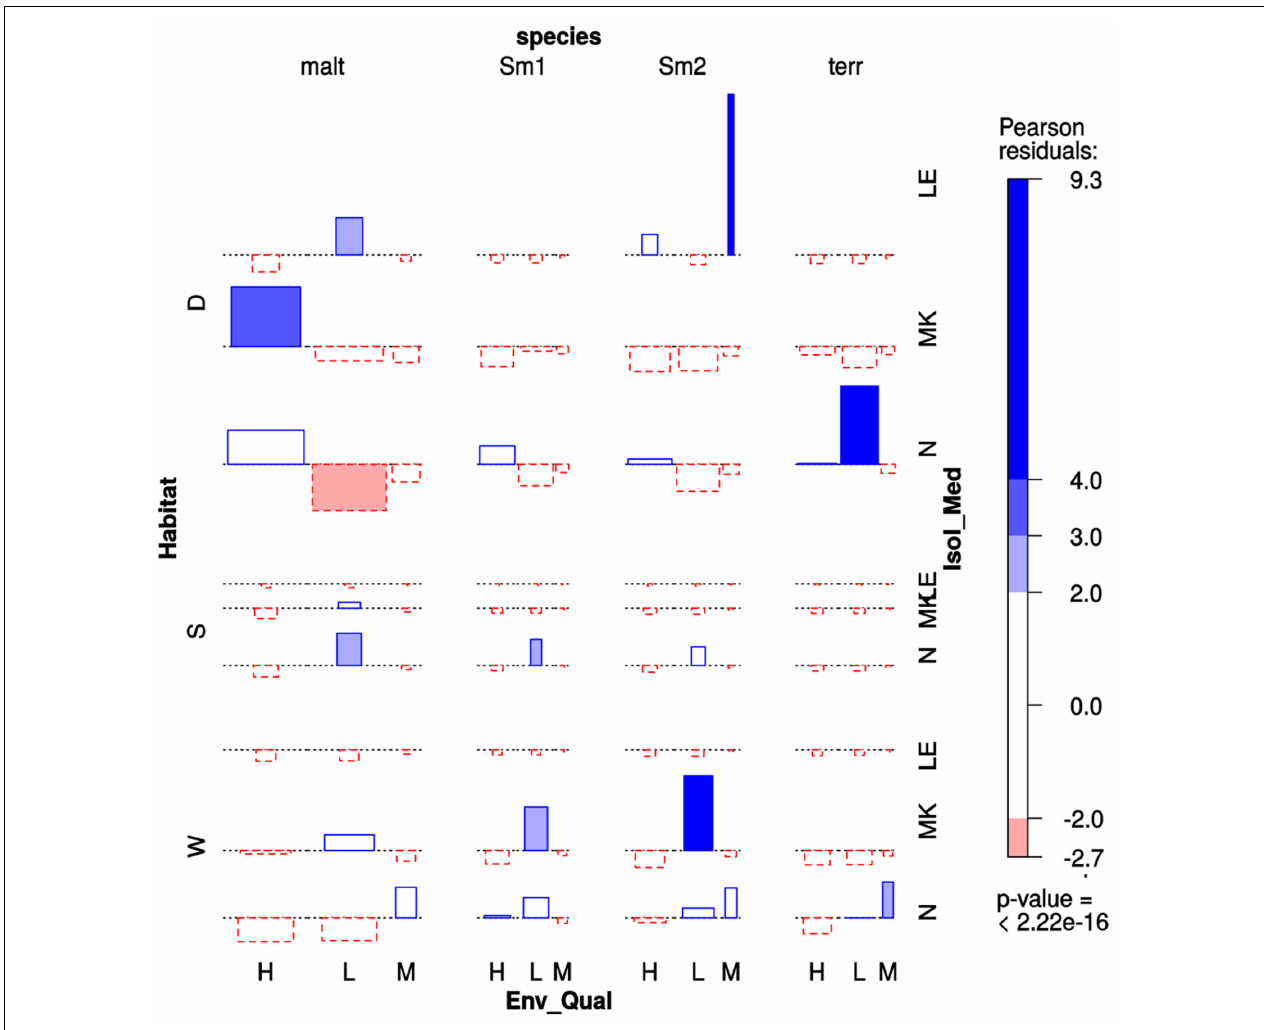
FIGURE 6 | Four-way association plot showing the results of multiway-chi-square analysis for the categorical variables species (abbreviations as defined in Figure 3 ), habitat (W = water column; S = flooded soil; D = sediment), isolation medium (N = NAA; MK = MacConkey; LE = Leed’s Medium) and pollution level (H = high; L = low; M = intermediate, based on counts of thermotolerant coliforms and E. coli , as defined in Table 1 ), using Friendly’s residual coloring scheme to highlight the significant associations. Species codes are as defined in Figure 3 . The bars on the plot represent the Pearson residuals, the color code and the height of the bars denote the significance level and magnitude of the residuals, and their widths are proportional to the sample size.